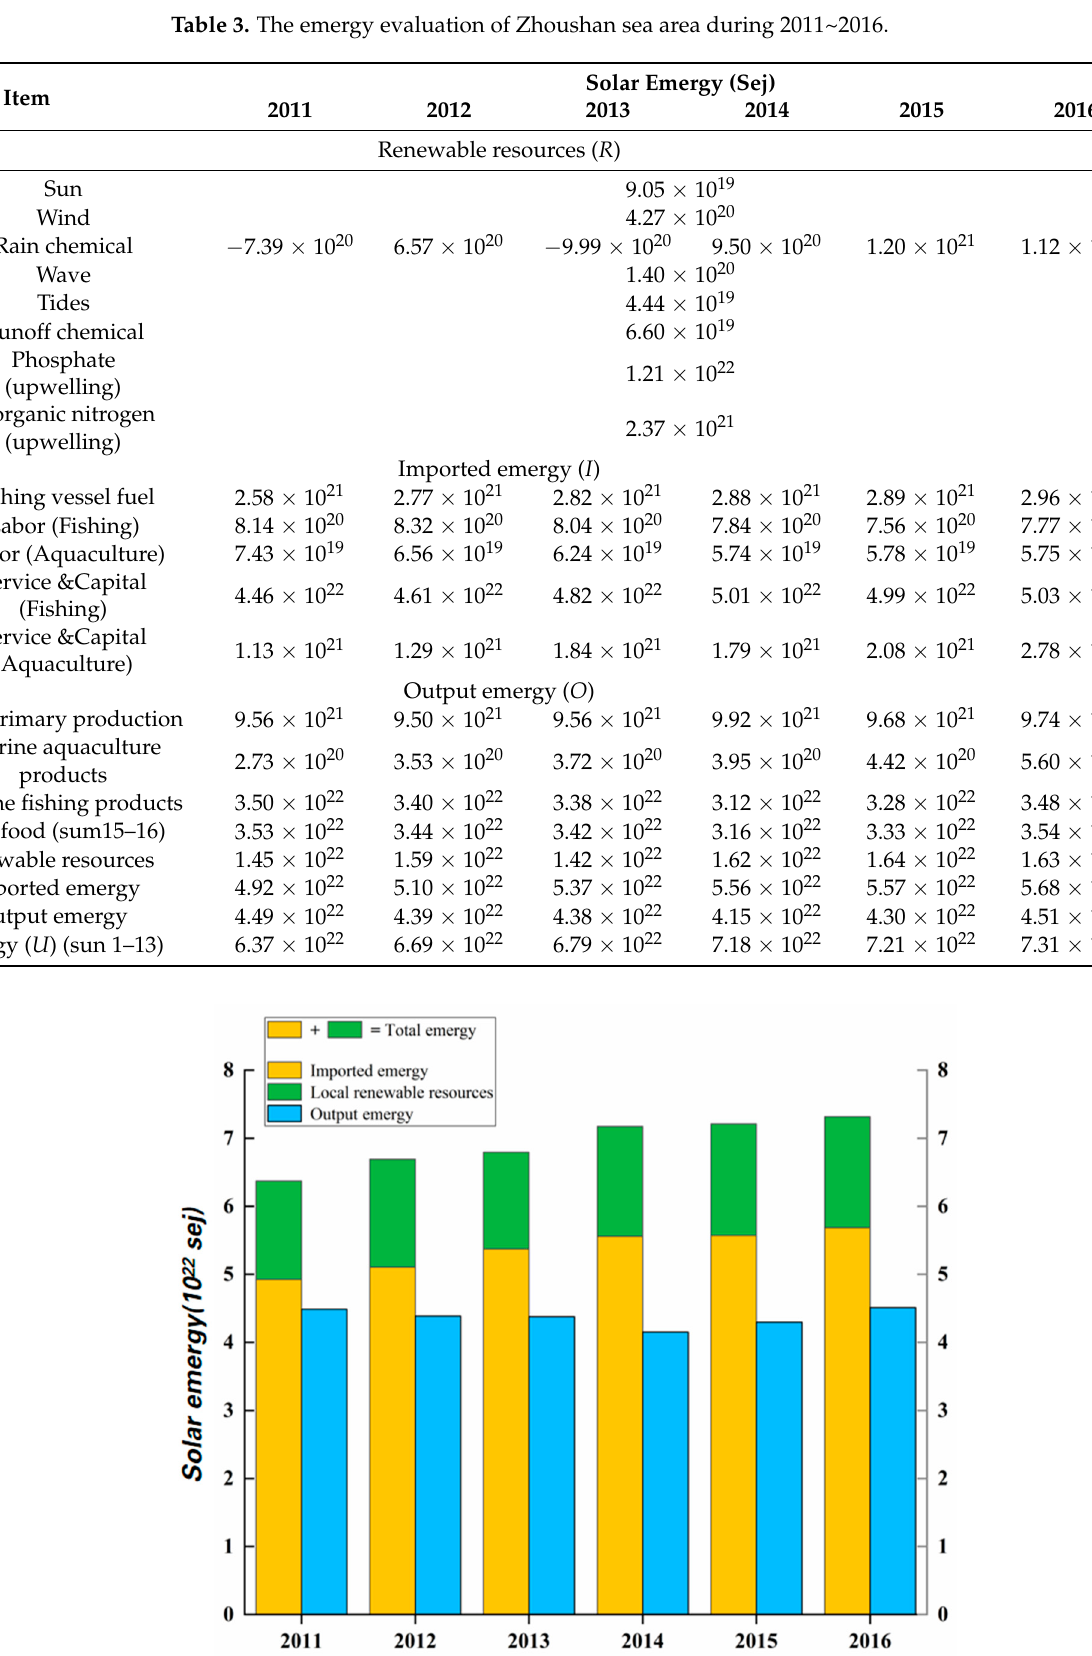
Figure 3. Integrated emergy flows of Zhoushan sea area from 2011 to 2016 . The output emergy is composed of net primary production and sea food. Unlike the stable increase in the total emergy, it decreased first and increased later in the six-year duration. The figures for 2011 and 2016 were basically the same (4.50 × 10 22 sej), while the lowest value appeared in 2014 (4.15 × 10 22 sej). Food is a very important gift from the sea, accounting for about 78%. However, sea food overharvesting has developed into a conta- gious resource exploitation model due to high global connectivity, advanced technology, and large market demand [58]. As we can see, the output of sea food has declined by 10.55% between 2011 and 2014, while in 2015, it increased significantly. In general, the fishery output in the Zhoushan sea area was basically maintained at a stable level. Table 3. The emergy evaluation of Zhoushan sea area during 2011~2016. Item